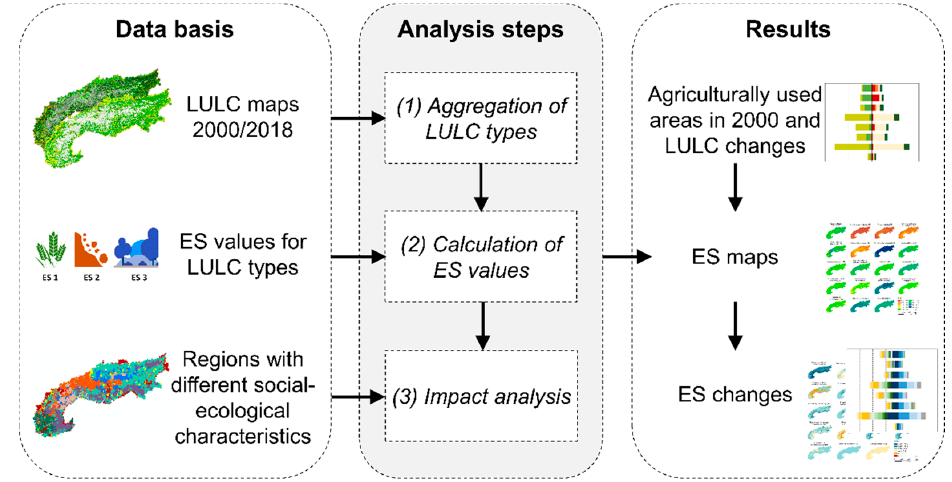
Figure 2. Conceptual steps for examining trends in ES values across different regions with distinct social–ecological characteristics in the European Alps, only considering areas that were agriculturally used in 2000. Authors own elaboration.